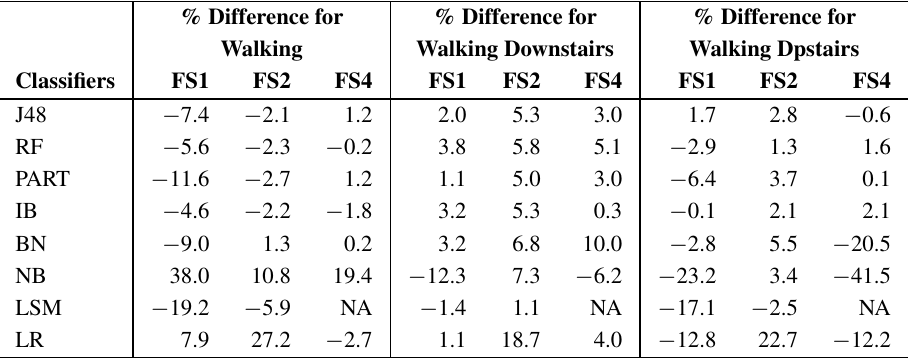
Table A.4. Performance difference (gyroscope—accelerometer) for the walking, walking downstairs and walking upstairs activities in Scenario B. % Difference for % Difference for % Difference for Walking Walking Downstairs Walking Dpstairs